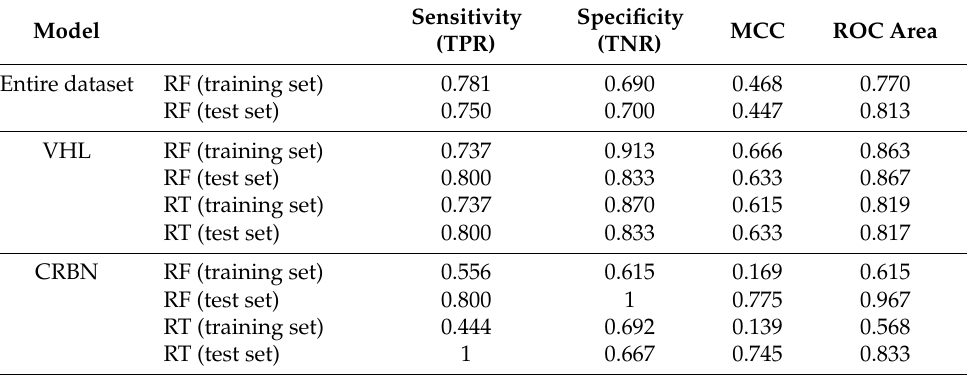
Table 1. Performance metrics for the best-performing classification models, with 75% degradation activity as active/non-active threshold for 0.1 µ M activity. Sensitivity refers to the ability of the model to correctly identify active compounds, and specificity refers to the capacity of discriminating non-active compounds from false negative ones. MCC is the Matthews Correlation Coefficient, and it represents how well the model can discriminate between the classes, active and non-active compounds. The ROC curve is a measure of sensitivity and specificity over a wide range of all possible threshold values [37]. RF: Random Forest classifier; RT: Random Tree classifier; VHL: Von Hippel-Lindau protein; CRBN: Cereblon protein. Model